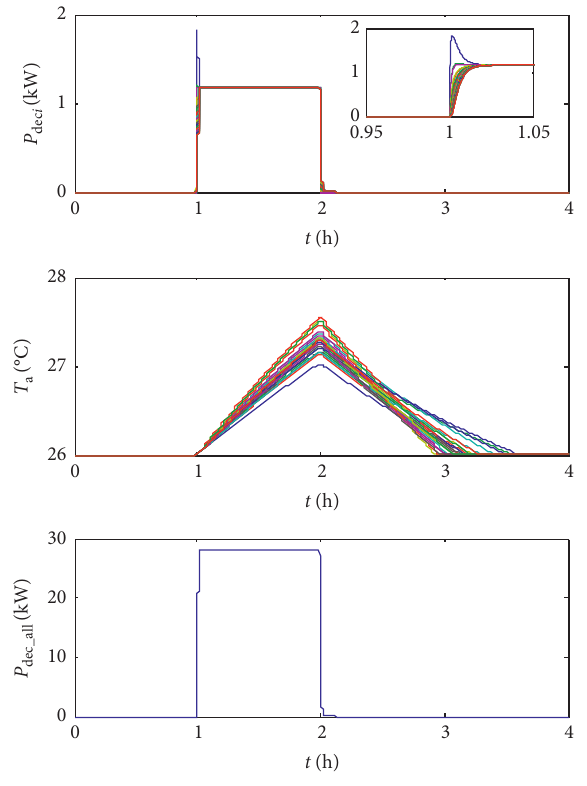
Figure 8: Simulation results of method 1.